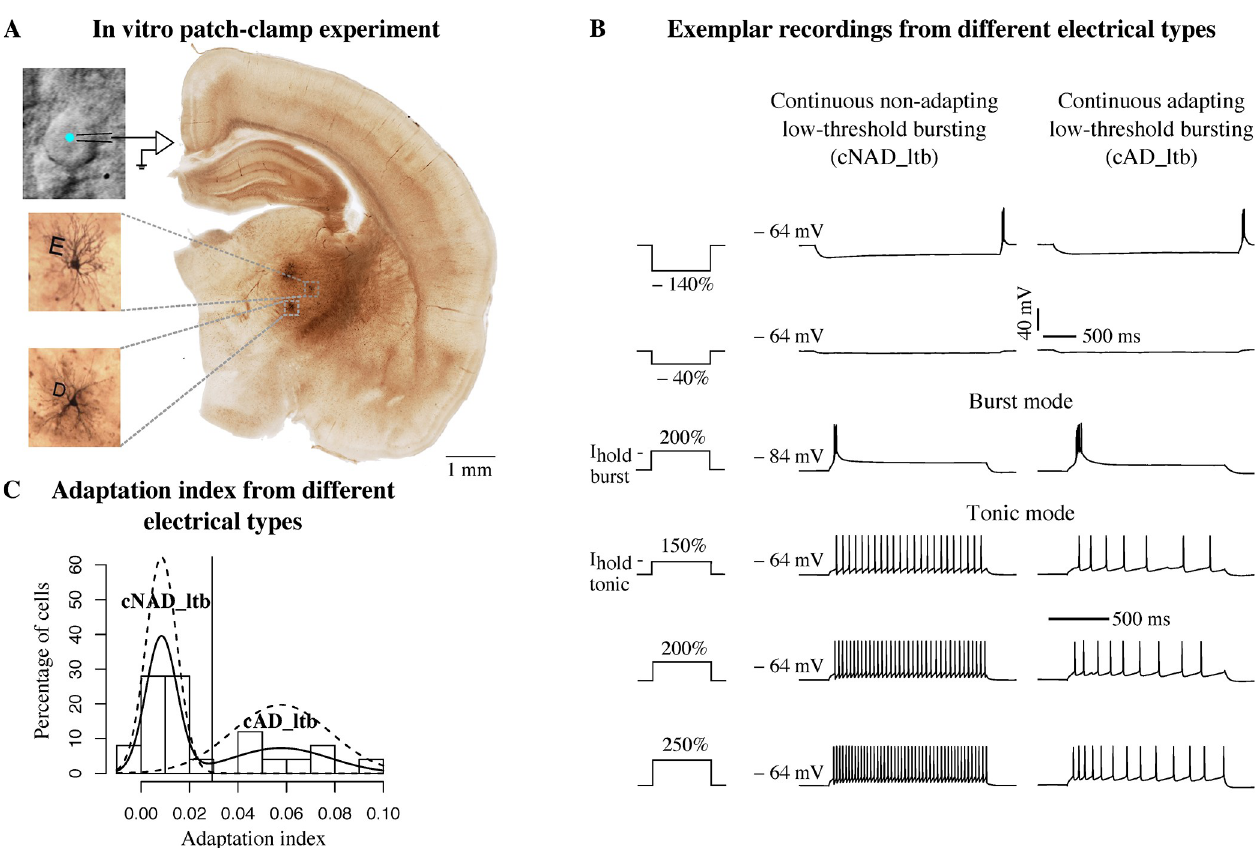
Fig 1. Simultaneous physiological and morphological characterization. (A) View of a patched cell under optic microscope and anatomical localization of biocytin-filled neurons (insets). Letters D and E identify morphologies in a slice. (B) Voltage responses of two different thalamocortical (TC) neurons to a standardized battery of current stimuli. Each current amplitude was normalized by the threshold current of each neuron (e.g. 150% threshold, see Methods). Third row is a low-threshold burst response from a hyperpolarized holding potential, V hold = − 84 mV (burst mode), the other responses are elicited from a depolarized holding potential, V hold = − 64 mV (tonic mode). Two different holding currents (I hold —tonic, I hold —burst) are injected to obtain the desired V hold . The vertical scale bar applies to all the traces, the first horizontal scale bar from the top refers to the first two rows, the second applies to the last four rows. (C) Analysis of adaptation index (AI) from recordings in tonic mode. Solid line is a non-parametric estimation of the distribution, dashed lines are two Gaussian distributions fitted to the data (see Methods). The vertical line indicates the cut-off